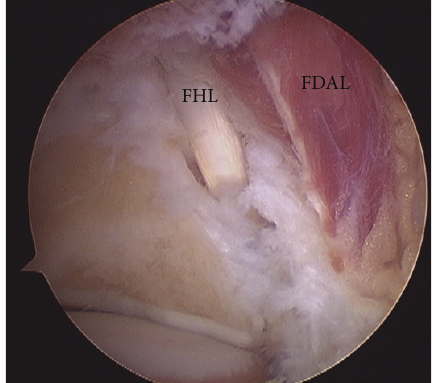
Figure 4: FHL and FDAL recognized.